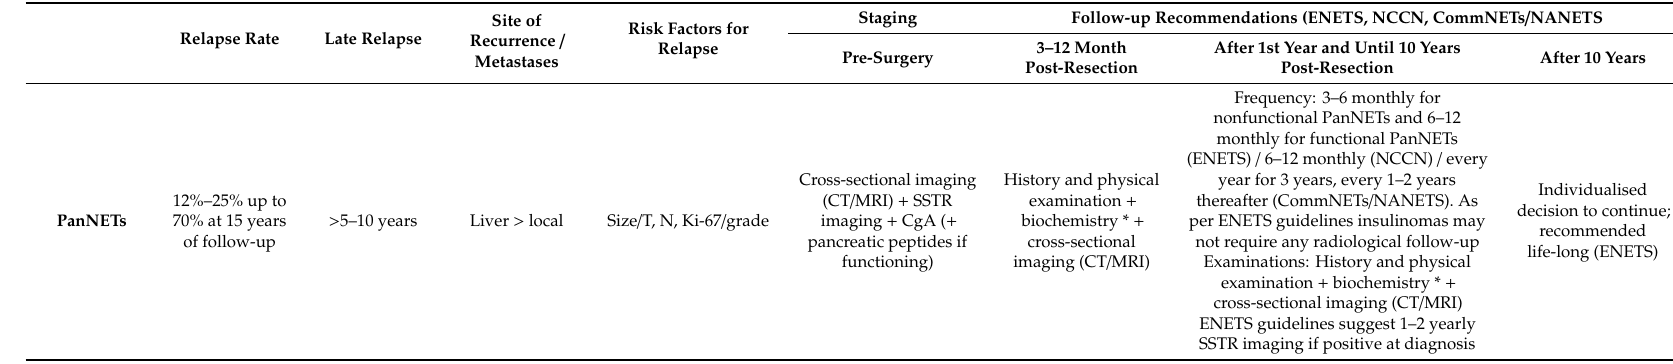
Table 3. Summary of patient outcomes and follow-up recommendations. Outcome data extracted from [30–35]. Recommendations adapted from